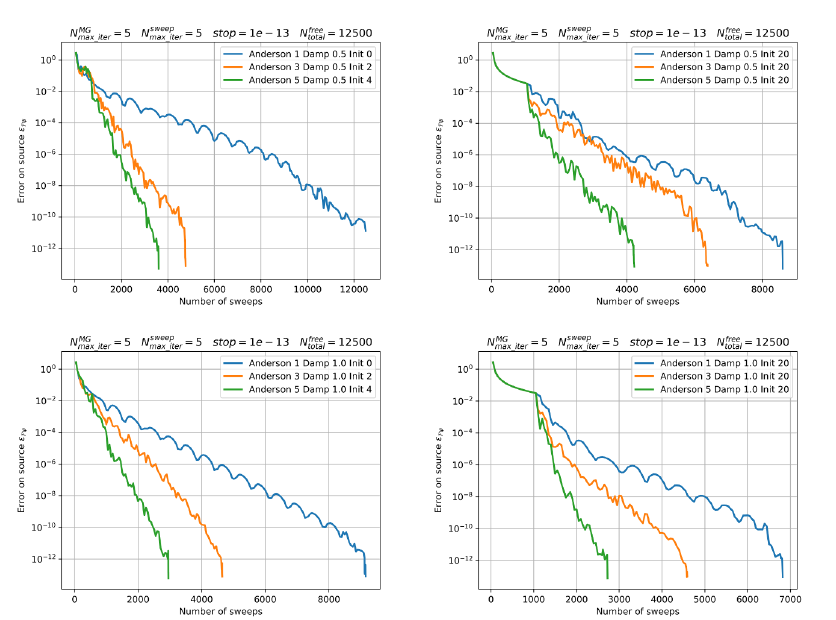
Figure 3: Effect of the damping ( β ) on the Anderson acceleration. Two sets of results are n = 0 . 5 with vector sizes of “as soon as possible” (left) and 20 (right), given: top row for β n = 1 . and below for β n